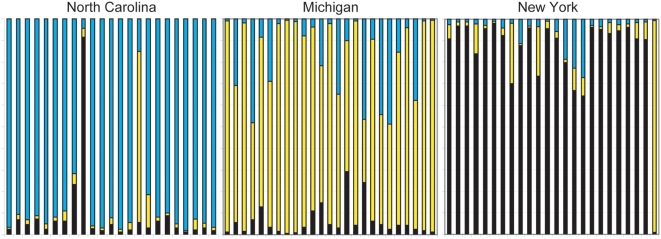
Estimated population structure among CD-1 mice.Each Cohort 2 individual is represented by a vertical bar that is partitioned into 3 colored segments (Black–NY, Yellow–MI, Blue–NC) to represent the individual's subpopulation membership. Breeding facilities are labeled above the panels. These results were consistent over 5 independent runs of the program.